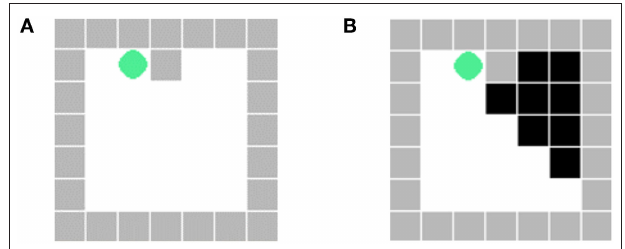
FIGURE 4 | (A) The actual position of the agent. (B) The view of the agent at the current position. The black part is the area blocked by the wall, which is invisible to the agent.